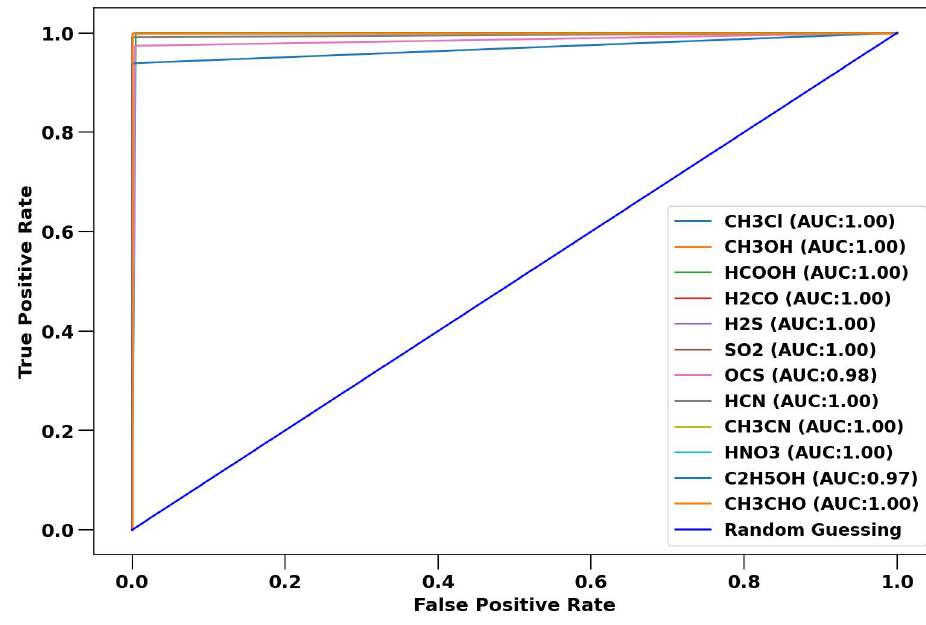
Figure 8. ROC curve for the classification of 1377 simulated training